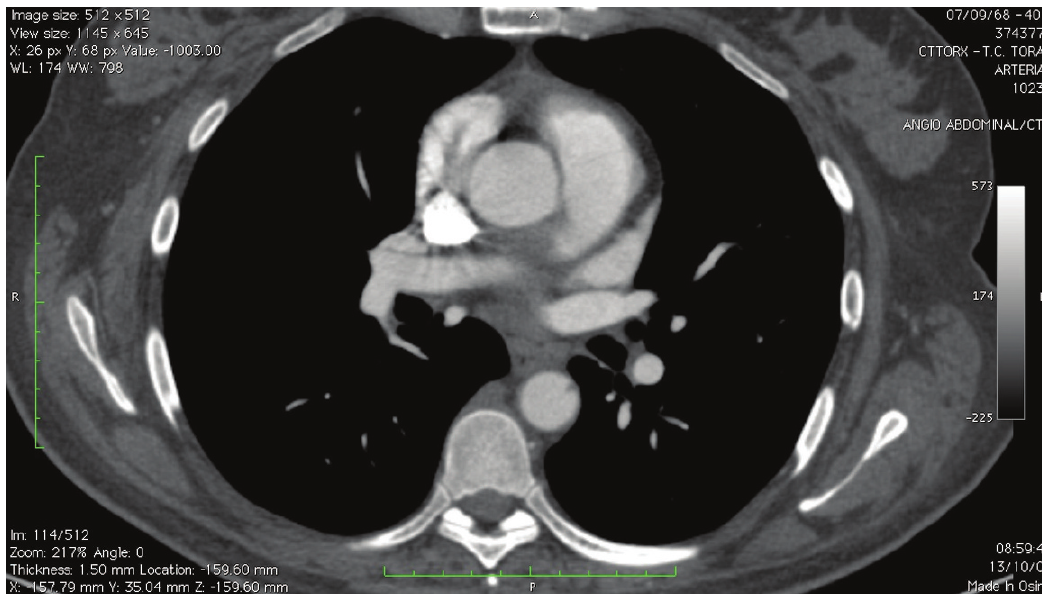
Figure 6 - Minimal aortic injury after 8 weeks – lesion healed.